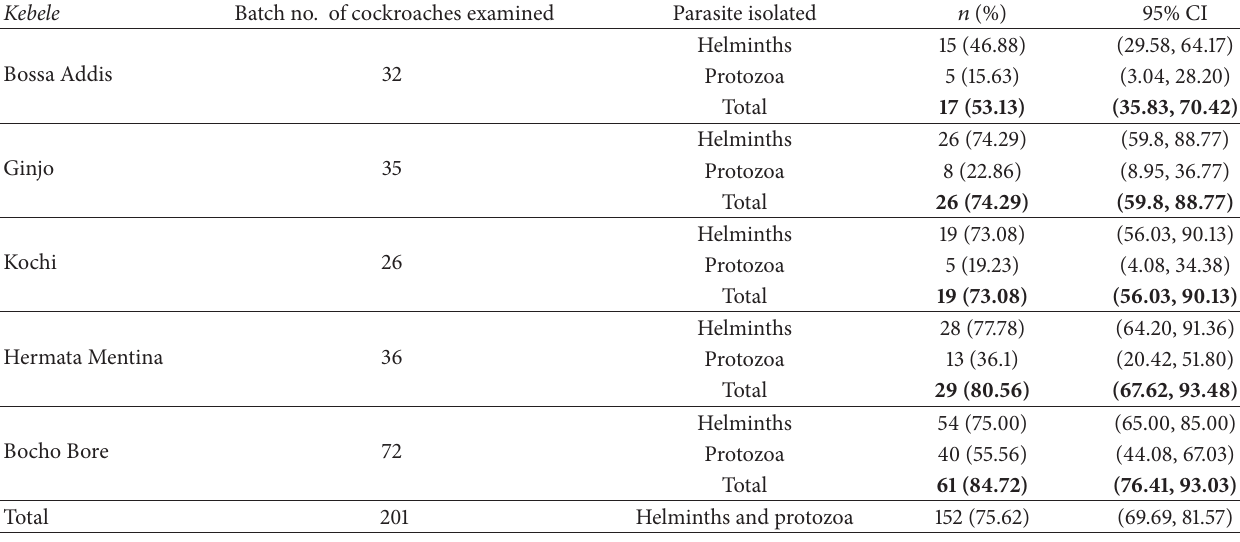
Table 1: Percentage of parasites isolated from populations of B. germanica by kebele in Jimma Town, southwestern Ethiopia, 2012. Kebele